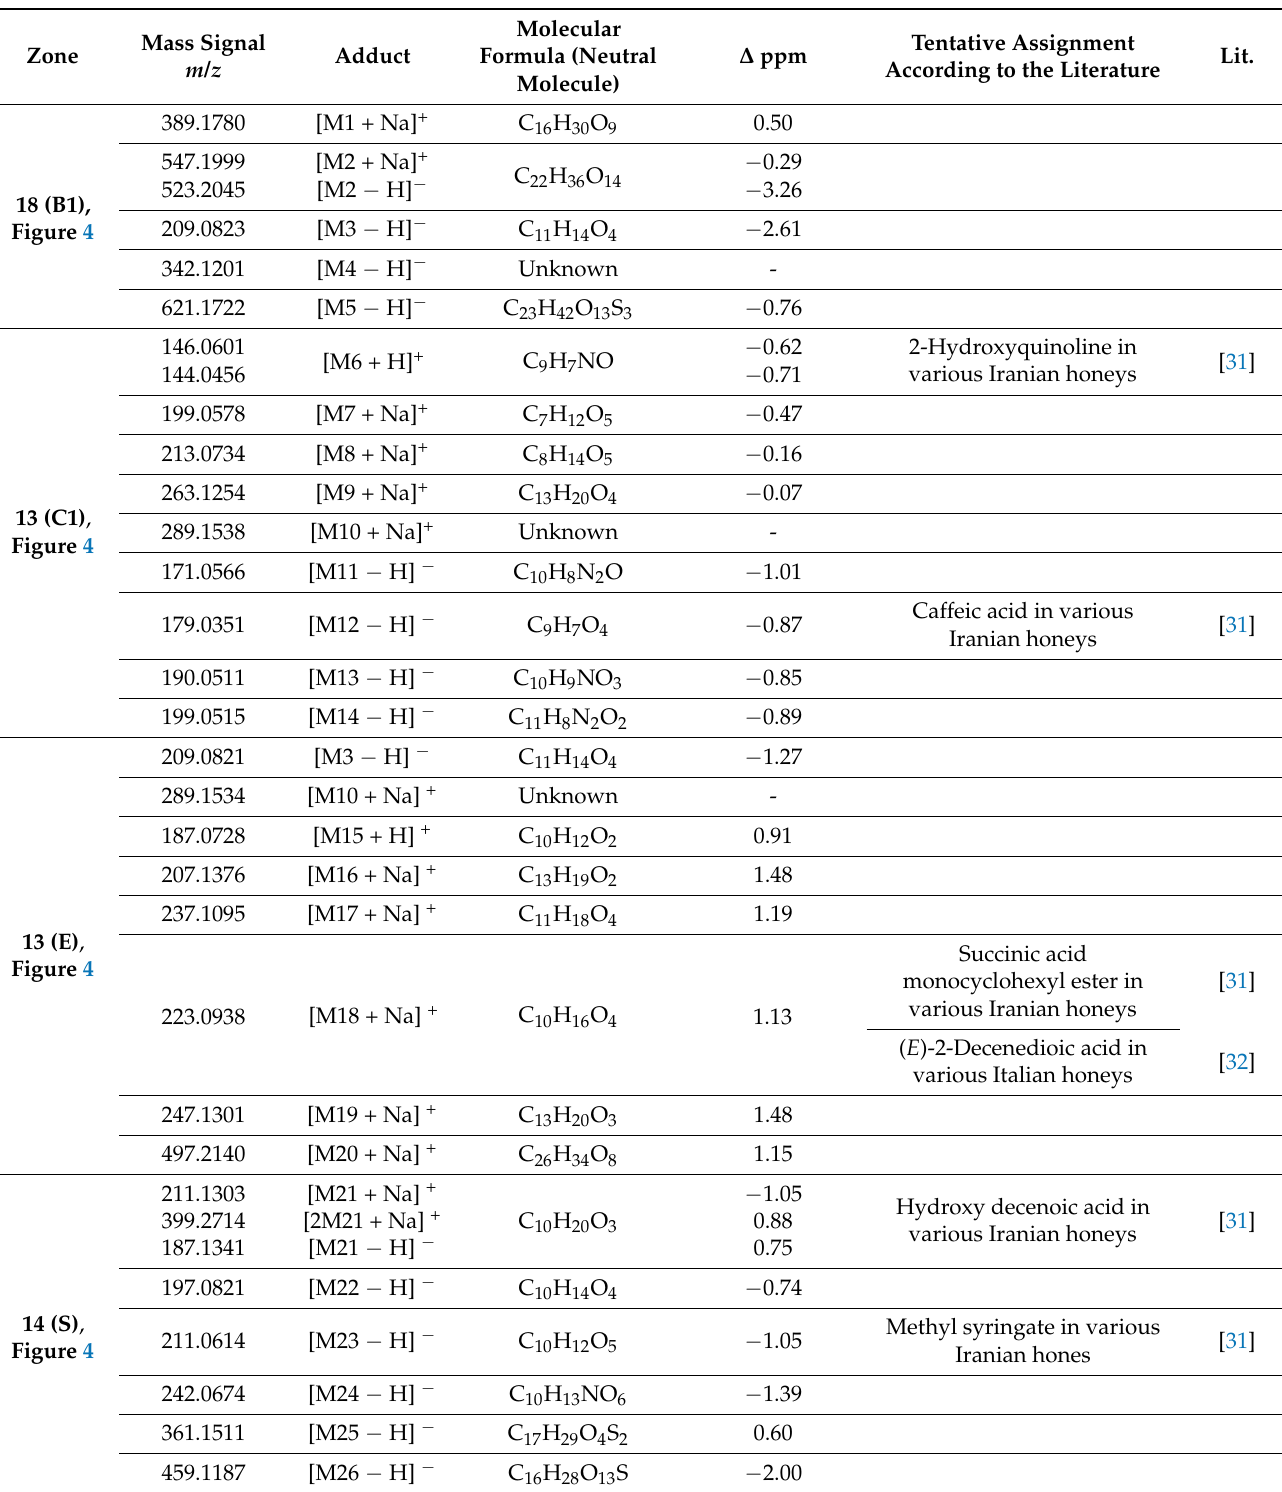
Table 4. Complete list of analytes found in the various honey samples and their tentative assignment to possible structures according to the